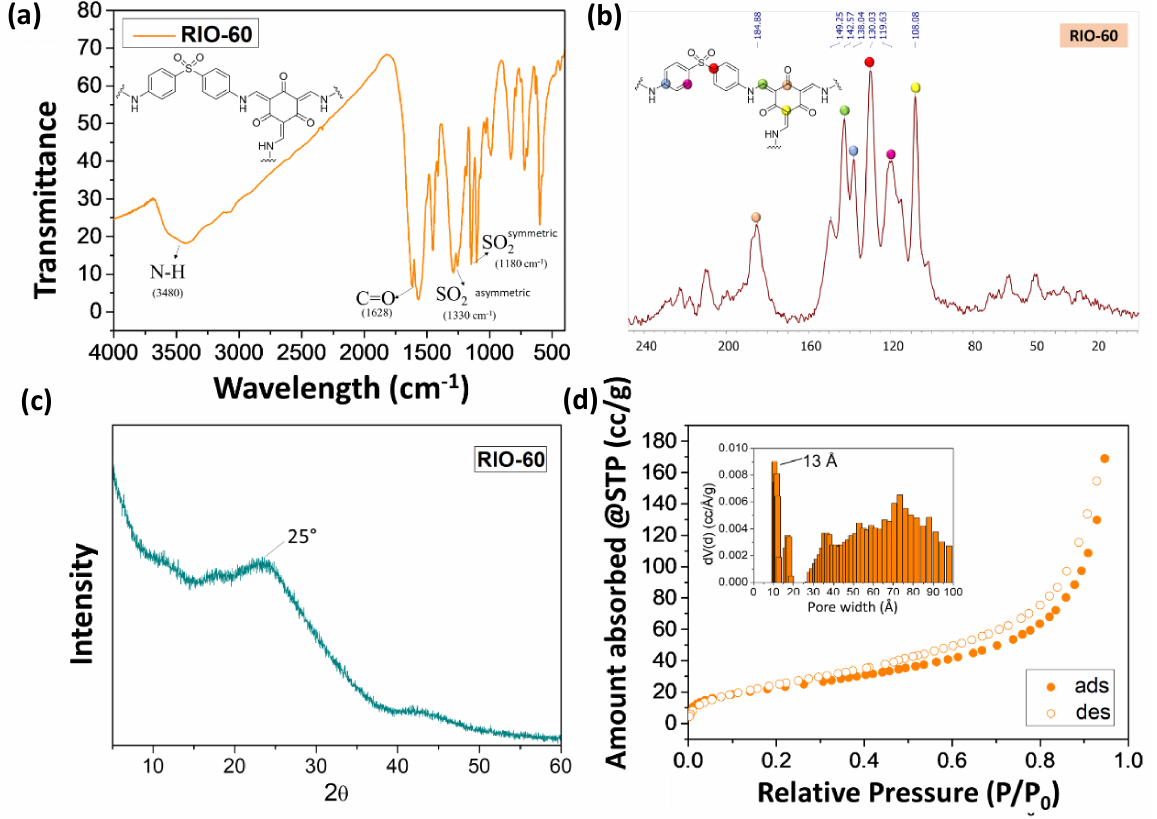
Figure 7. Characterization of RIO-60: ( a ) FTIR, ( b ) solid state 13 C NMR, ( c ) PXRD, and ( d ) the BET method used for surface area N 2 adsorption–desorption isotherm and pore size distribution.